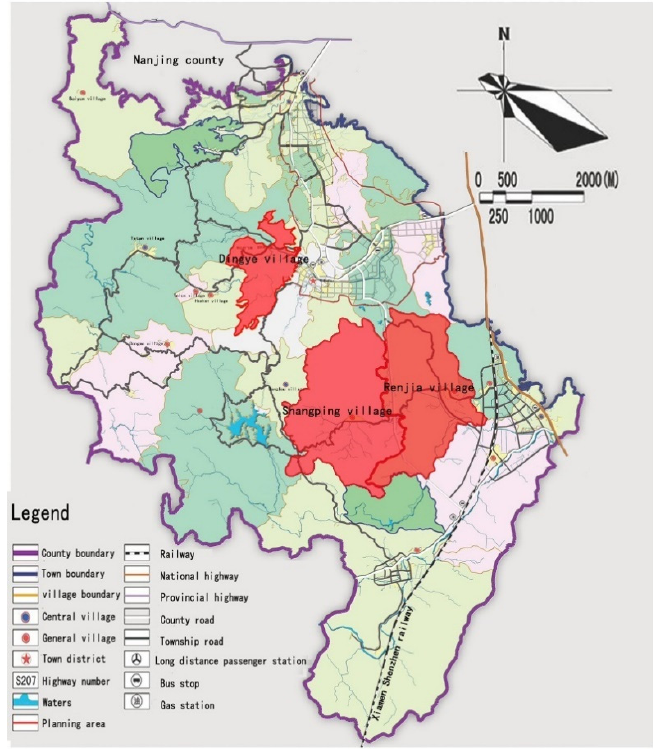
Figure 2. Research area.